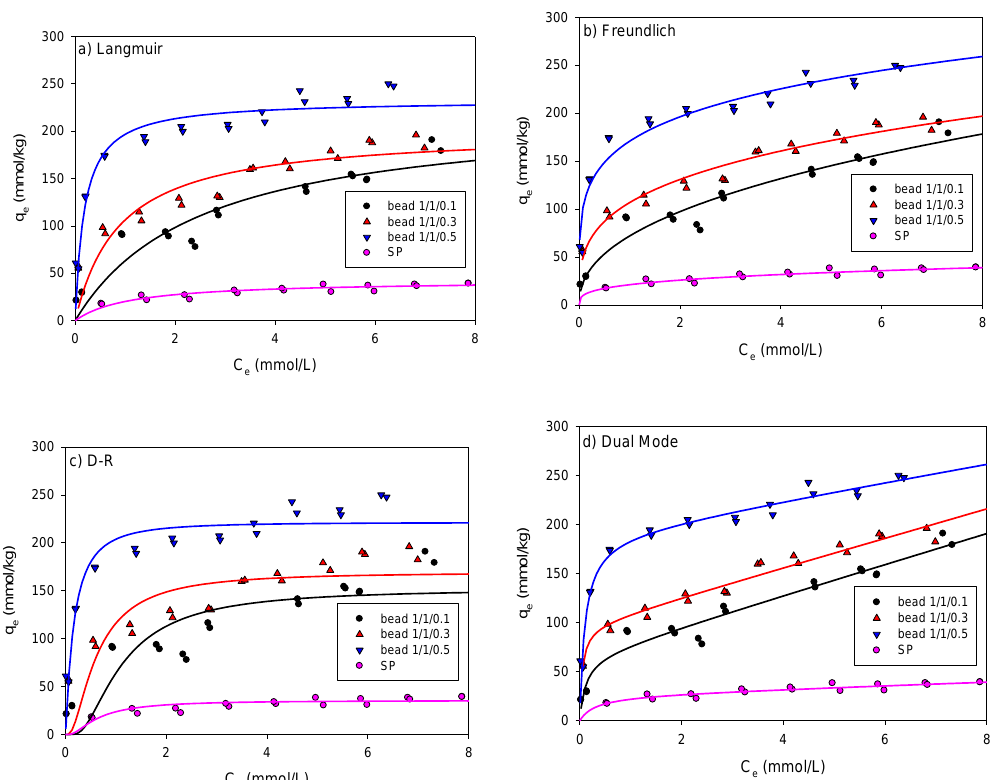
Figure 5. Nonlinear fitting of the ( a ) Langmuir; ( b ) Freundlich; ( c ) D-R; and ( d ) the dual mode models for Pb adsorption onto the beads and SP.